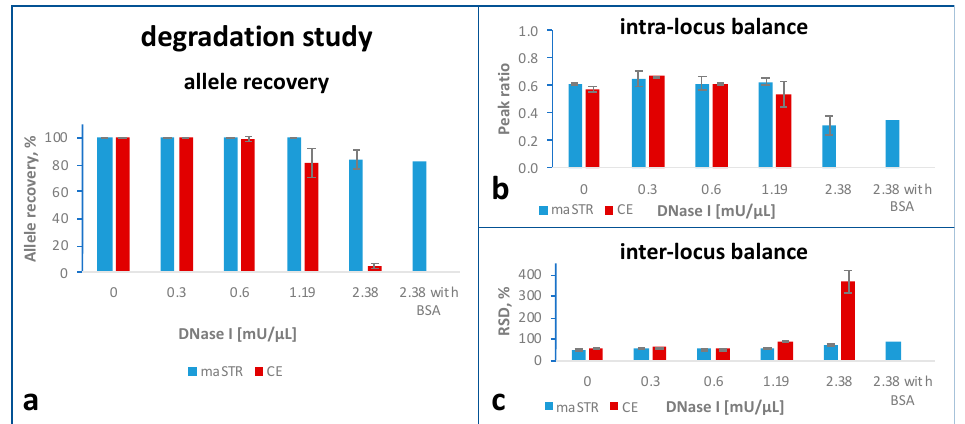
Figure 2. Degradation study comparing STR typing using maSTR assay (two replicates; blue bars) or CE with PowerPlex ESX17 kit (three replicates; red bars). Human DNA was incubated with the DNase I concentration indicated. For DNA samples treated with 2.38 mU µl − 1 DNase I, the PCR buffer of the maSTR assay was in addition supplemented with 0.6 µM BSA. Error bars represent standard deviations. ( a ) Comparison of allele recoveries, which are the percentages of correctly called alleles. ( b ) Intra-locus balance, calculated as the ratio of the peak heights (or of the sequence read numbers for maSTR assays) of the allele with the lower RFU value (or lower number of reads) by the peak of the allele with the higher RFU value (or higher number of reads). ( c ) Inter-locus balance, expressed as the relative standard deviation (RSD) of the mean values (of RFUs or read numbers) of all loci.